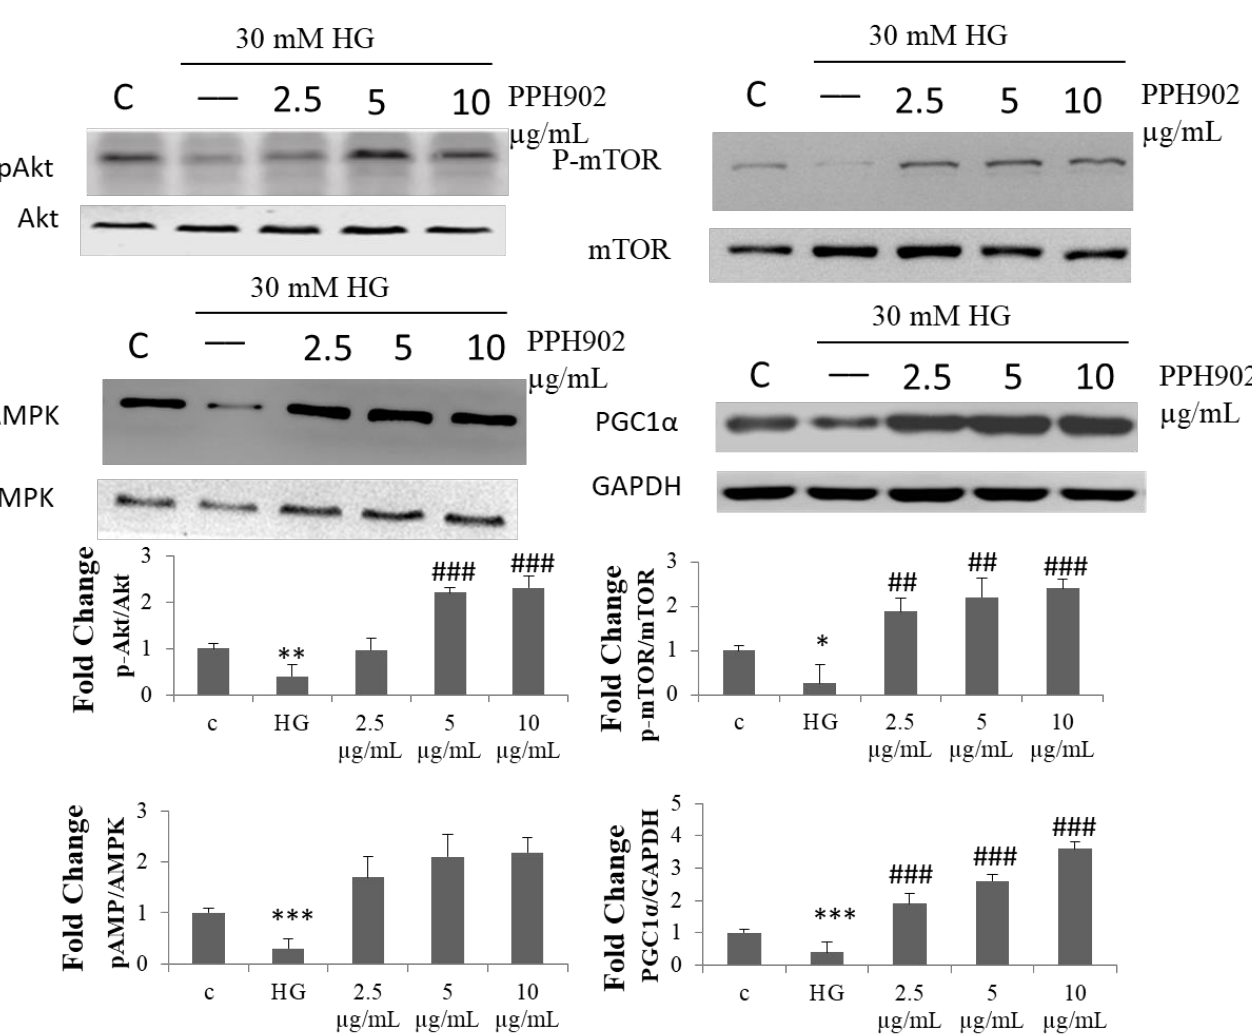
Figure 7. PPH902 reverses high-glucose-induced suppression of protein synthesis machinery in C2C12. Western blotting analysis shows modulations in the levels of pAkt, p-mTOR, p-AMPK and PGC1α. *** p < 0.001, ** p < 0.01 and * p < 0.05 indicate significant differences with respect to control groups; ### p < 0.001 and ## p < 0.01 indicate significance differences with respect to the high glucose challenge groups.